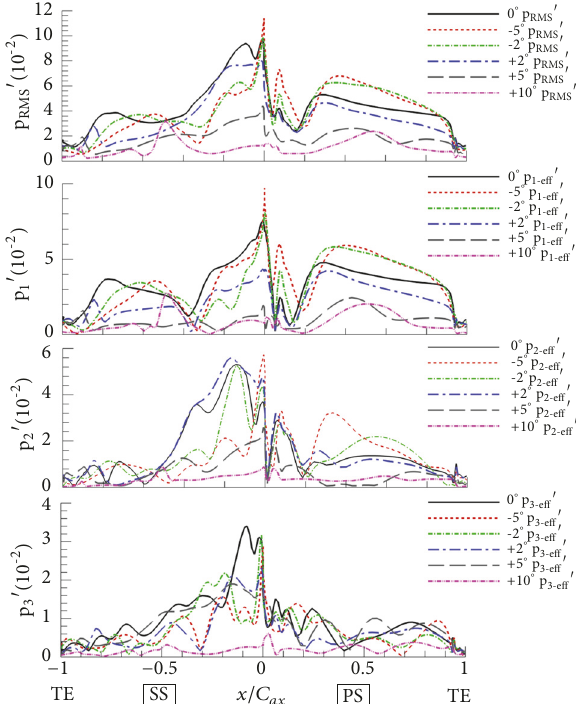
Figure 10: Pressure amplitude distribution along the rotor blade midspan at nominal pressure ratio of